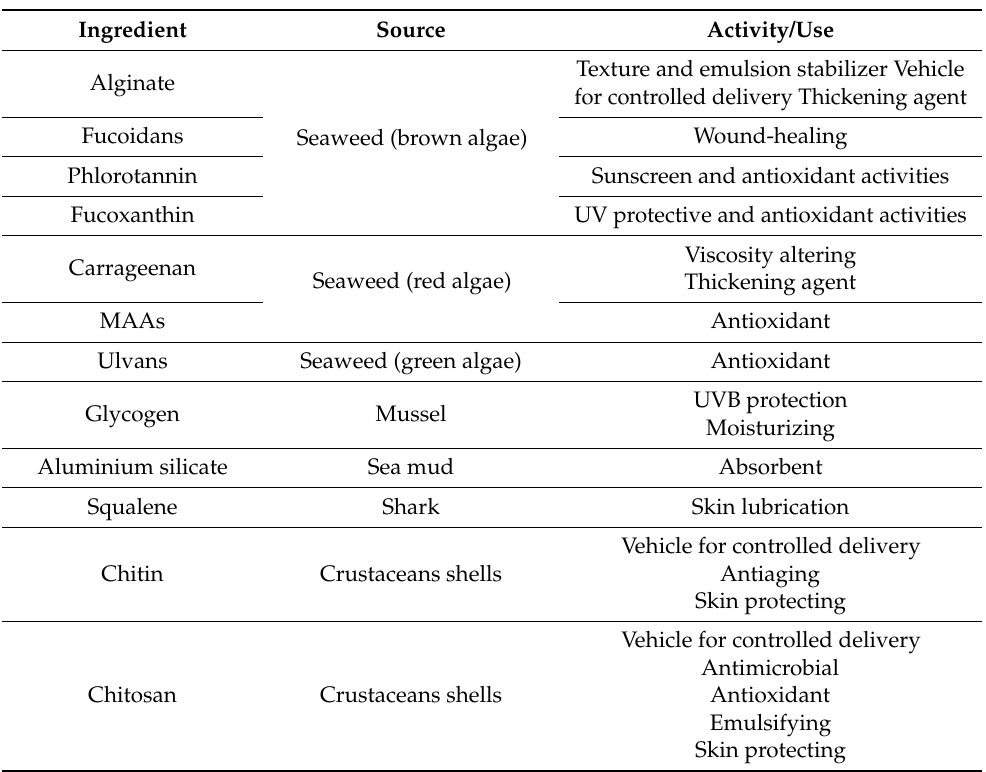
Vehicle for controlled